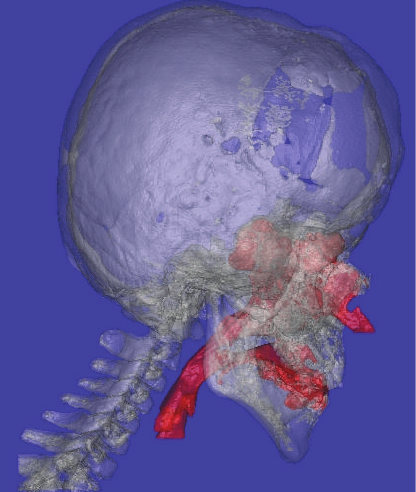
Figure 5: A side view of a three-dimensional computed tomography image obtained after surgery. Maxillary hypoplasia is mostly recti- fied compared with that before surgery.